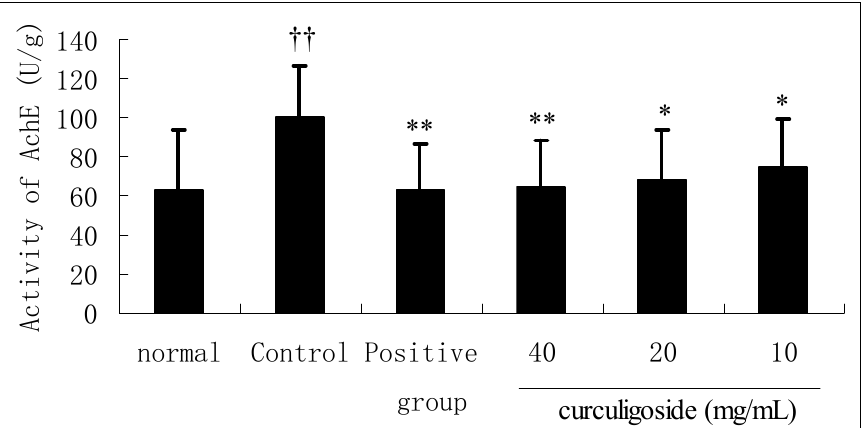
Rats were divided into six groups; normal and control groups were treated with physiological saline (10 mL/kg/d) orally; donepezil was used as positive control and administered (0.4 mg/kg/day) orally; curculigoside groups were administered (40, 20 and 10 mg/kg/day) orally. Values are Mean ± S.E.M. (n = 10); * p < 0.05, and ** p < 0.01 compared with the control group, and †† p < 0.01, compared with the normal group. Figure 5. The effect of curculigoside on expression of BACE1 in aged rats.